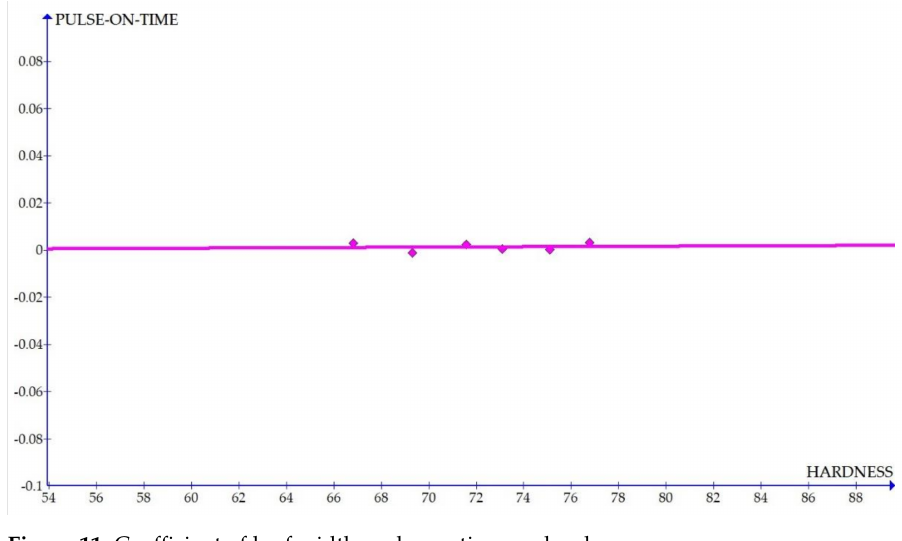
Figure 11. Coefficient of kerf width: pulse on time vs. hardness.